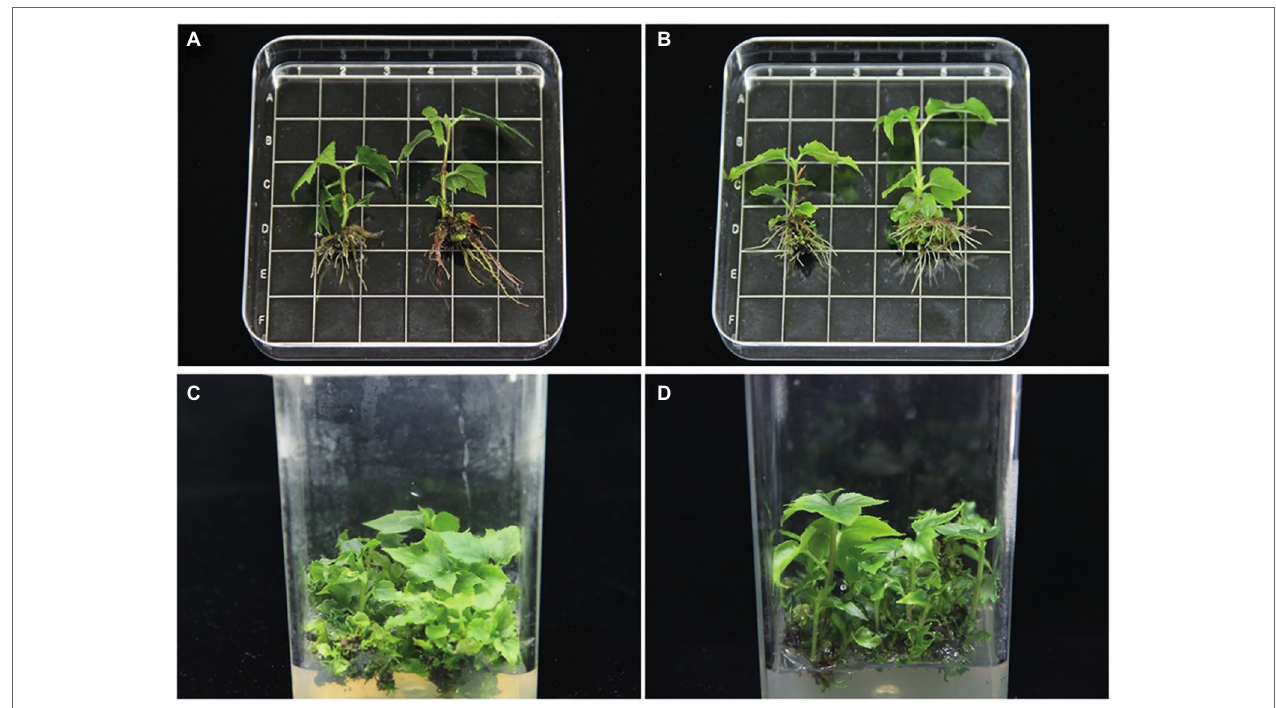
FIGURE 10 | Effects of GA 3 and IAA on shoot and root lengths of tetraploid hybrid sweetgum Z4 grown in vitro (A,B) . (A) Control on the left (primitive rooting medium) and rooting medium supplemented with 0.5 mg/L GA 3 on the right. (B) Control on the left (primitive rooting medium) and rooting medium supplemented with 0.5 mg/L GA 3 and IAA on the right. Area of each square: 1 × 1 = 1 cm 2 . Effects of GA 3 on adventitious bud length in tetraploid hybrid sweetgum (C,D) . (C) Control. (D) Development of adventitious shoots in medium supplemented with 0.5 mg/L GA 3